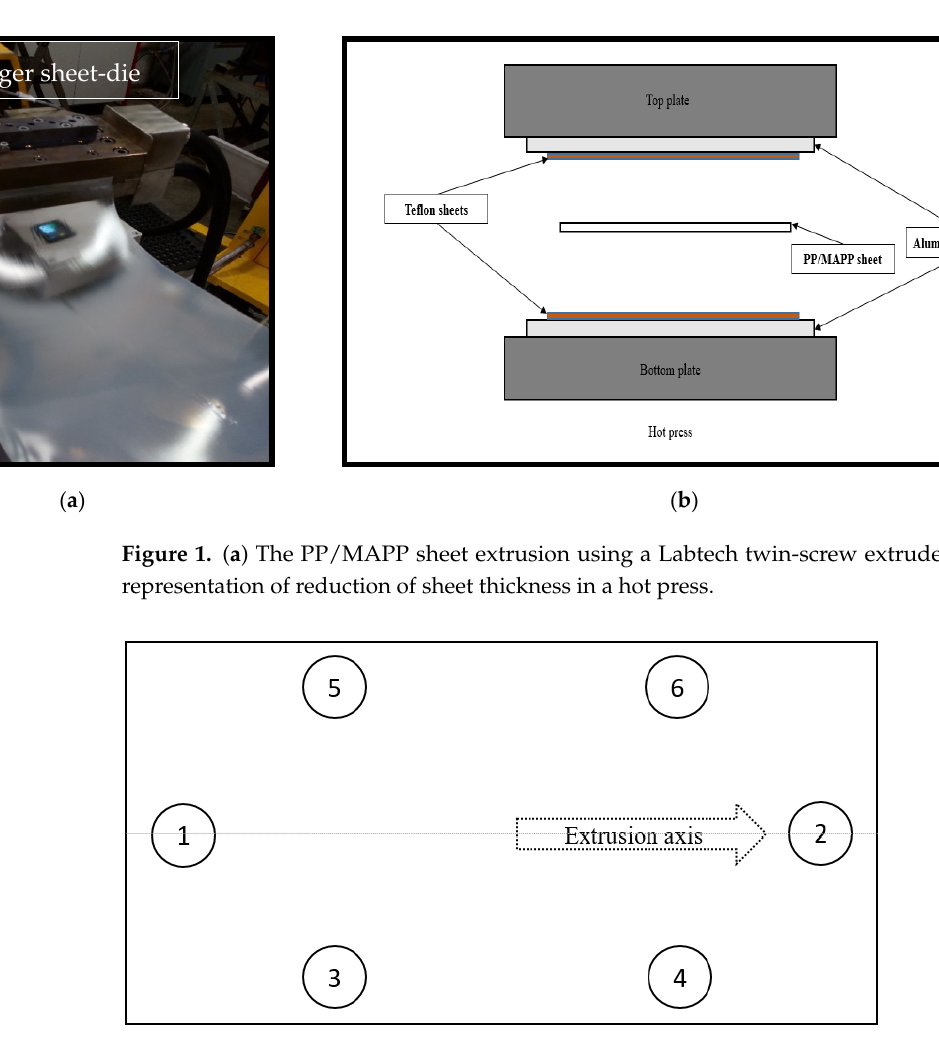
Figure 2. Schematic diagram showing different locations from where the measurements were taken out to obtain the average thickness of the sheets.